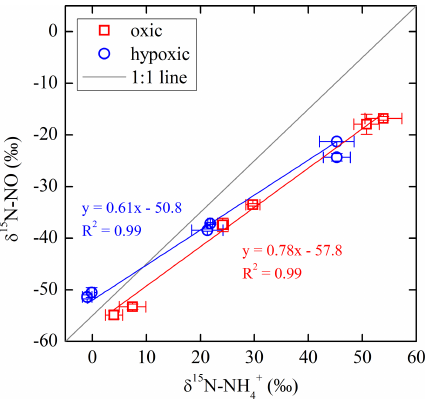
Figure 4. δ 15 N-NO as a function of δ 15 N-NH + hypoxic